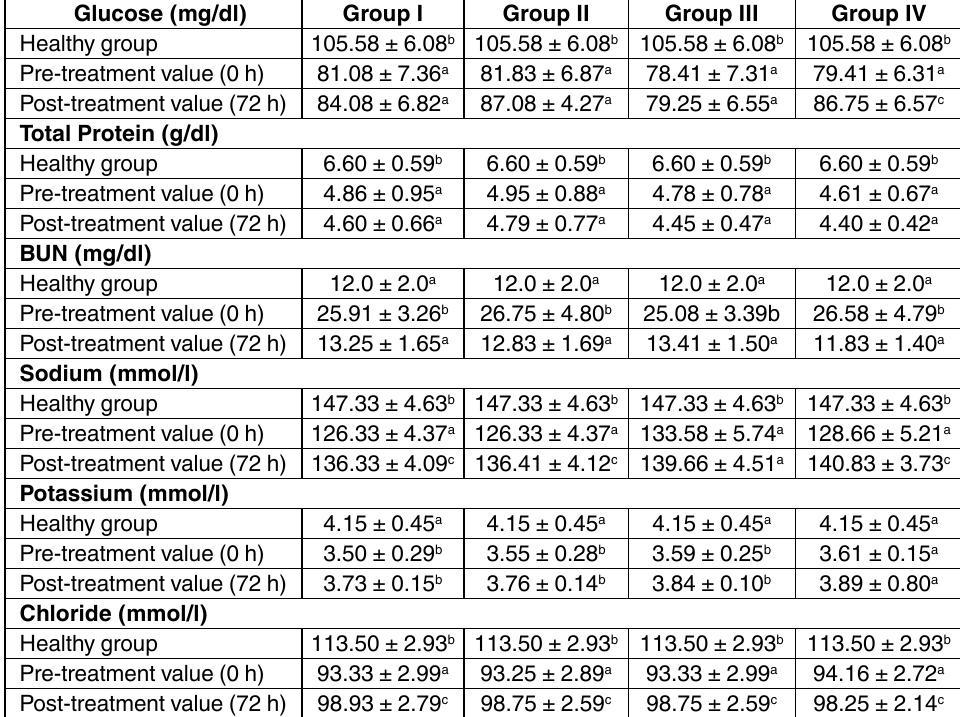
table 7. Effect of treatment on blood biochemical profile (Mean ± S.D.) (n=12) in CPV